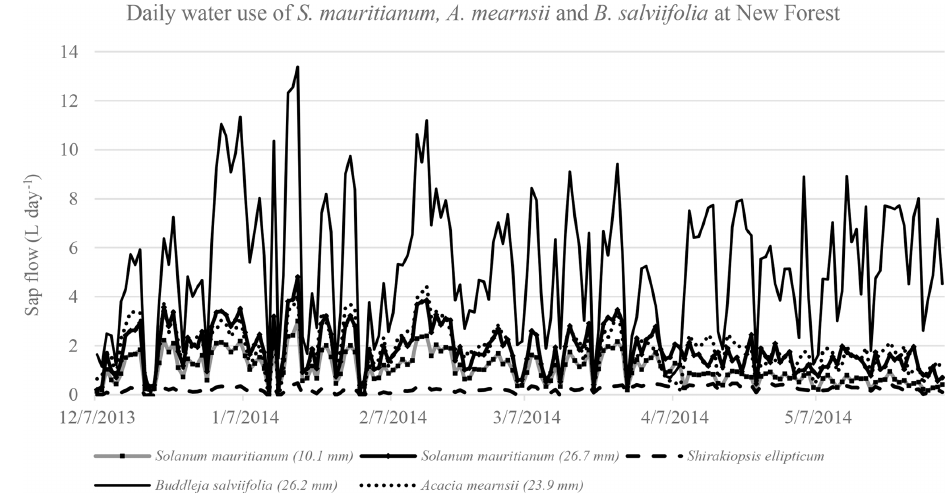
Figure 7. Daily water use for three S. mauritianum , a multi-stemmed B. salviifolia and an A. mearnsii using the SSS technique.